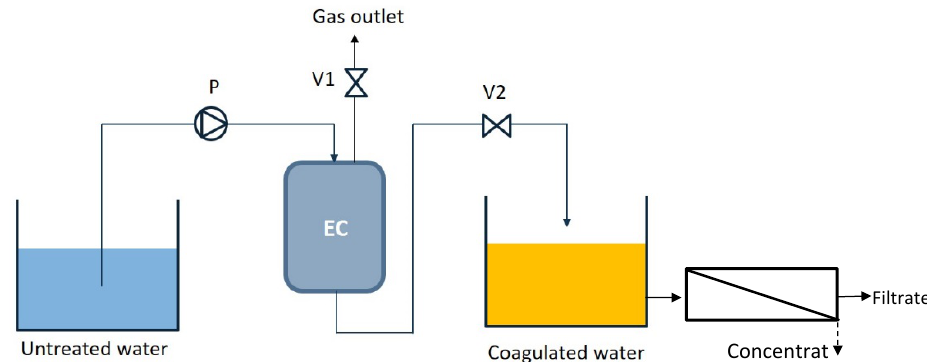
Figure 1. Schematic diagram of the electrocoagulation unit with optional membrane filtration. As reflected in Figure 1, the watering period starts with pump P transferring feed water from the feed water tank (untreated water) to the EC reactor through the inlet at the top. The setup was chosen in order to avoid clogging and sedimentation when just low flow velocities are applied. Then, the coagulated water leaves the reactor through the water outlet at the bottom of the reactor, and through an open water outlet valve V2, while a gas outlet valve V1 is closed. The coagulated water is collected in a tank, which might also be used to feed a membrane system. Meanwhile, gas bubbles accumulate in the reactor over the watering period. For the degassing period, the water outlet valve V2 is closed, and the gas outlet valve V1 is opened. Consequently, the deposited bubbles are gradually vented out through the gas outlet. Operating conditions of the EC reactor is shown in Table 1, whereas six different experiments have been investigated with different flow rates in this